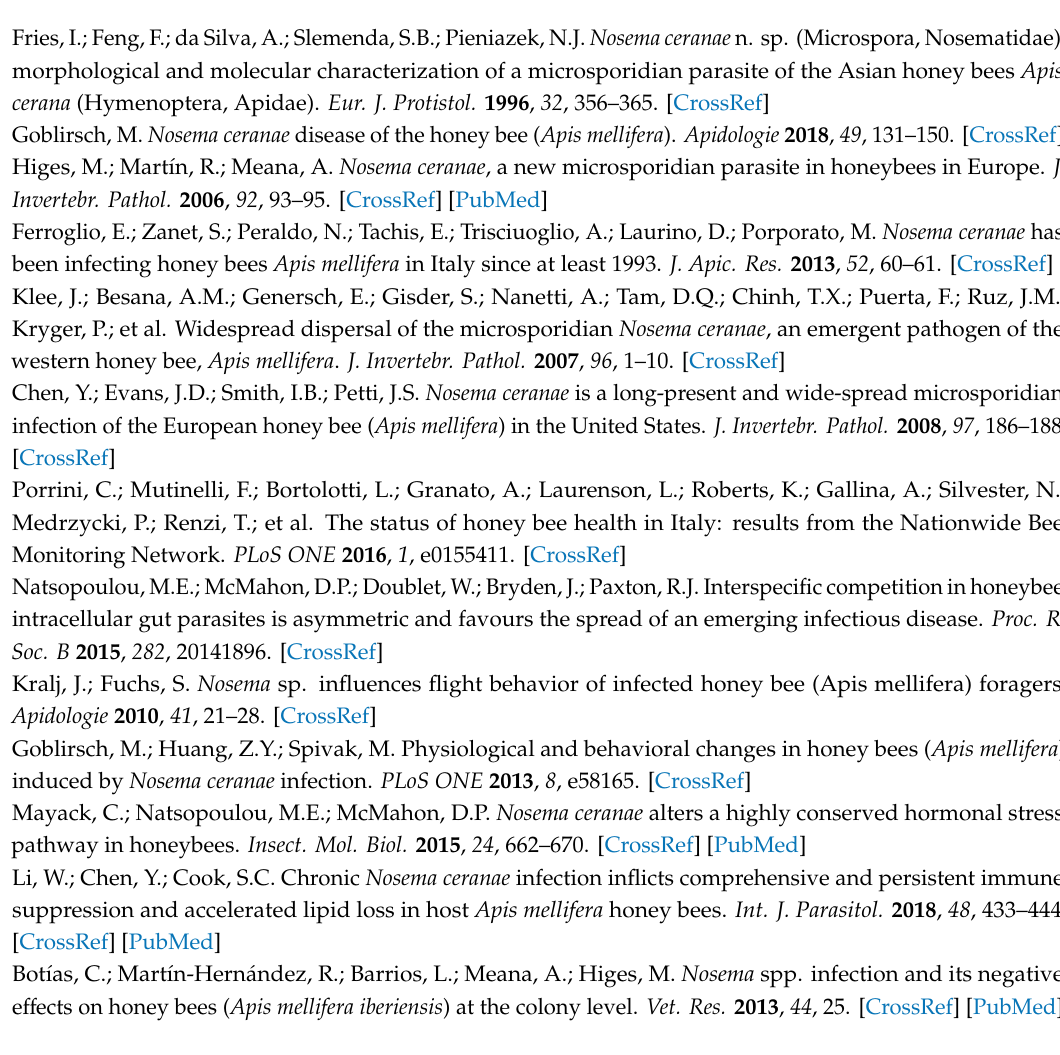
Table S1: Results of post-hoc tests adjusted for multiple comparisons with the FDR method, of di ff erences in the hazard ratio of each treatment in the survival